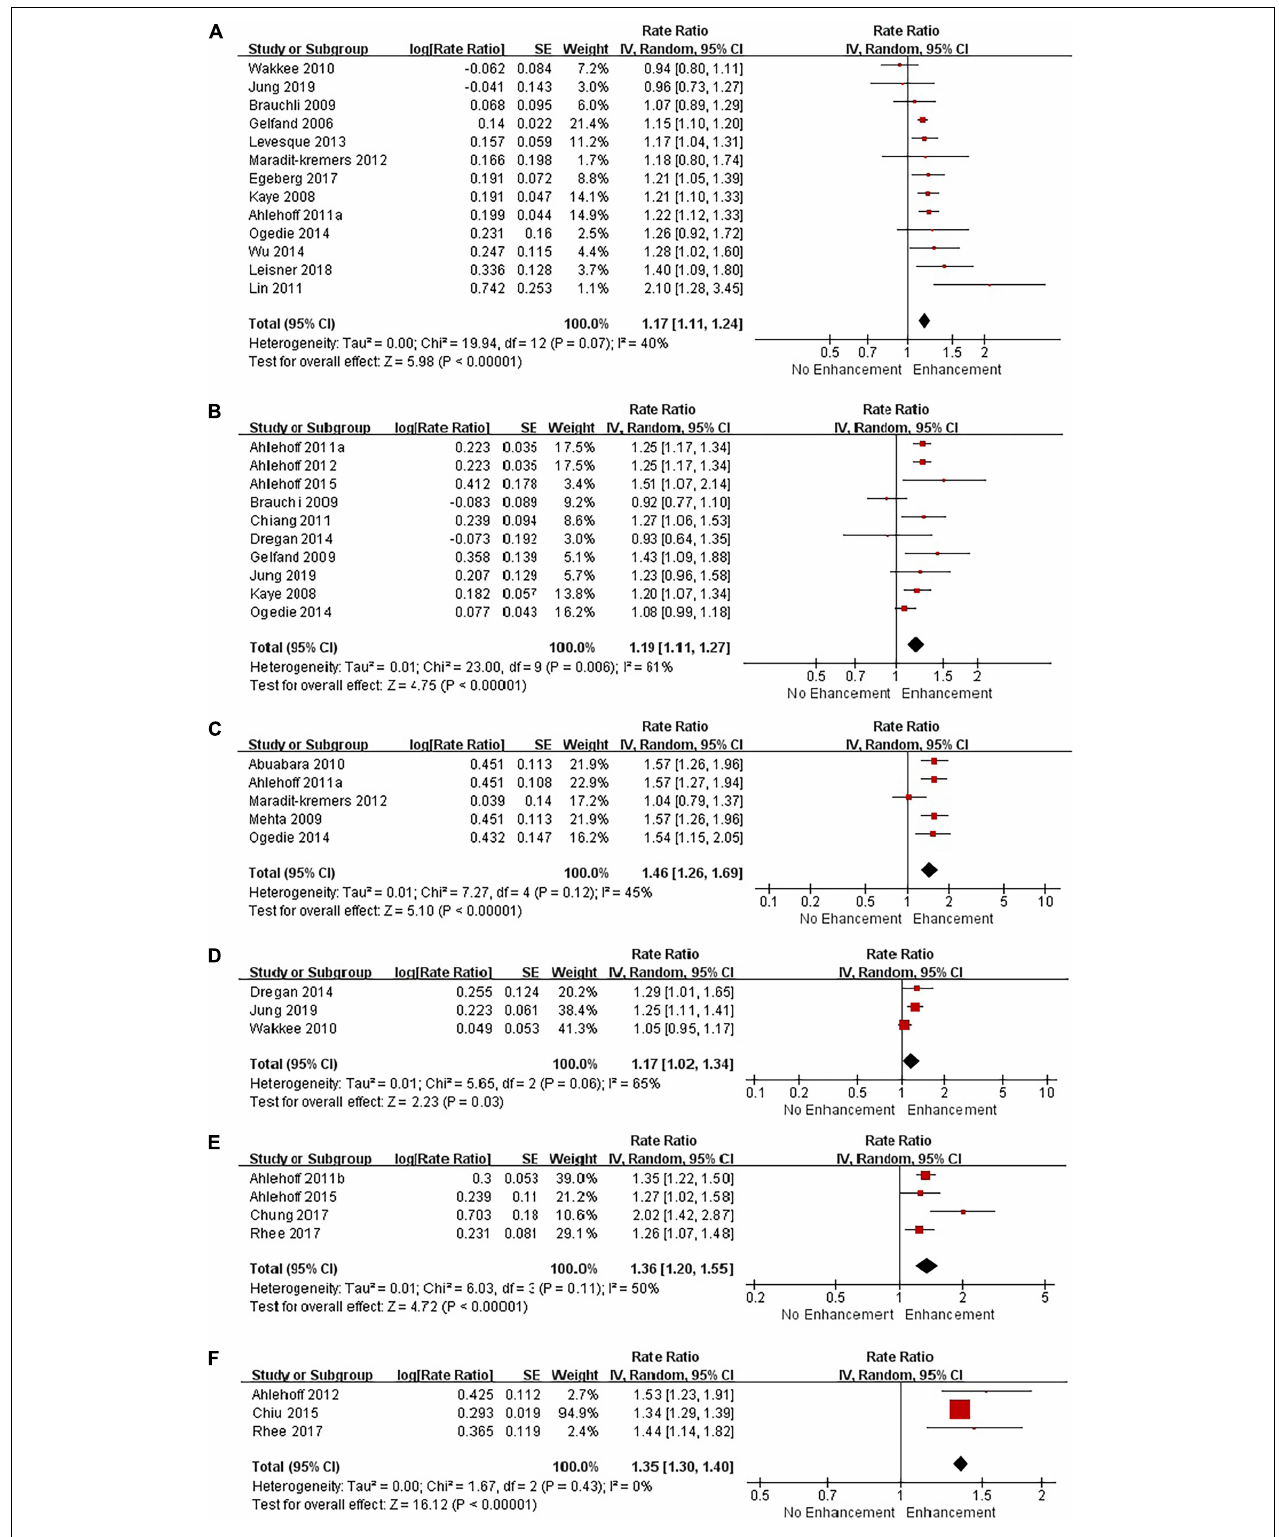
FIGURE 3 | Forest plot of adverse cardiovascular outcomes based on Review Manager. (A) Risk of myocardial infarction in patients with psoriasis; (B) risk of stroke in patients with psoriasis; (C) risk of cardiovascular death in patients with psoriasis; (D) risk of ischemic heart disease in patients with psoriasis; (E) risk of thromboembolism in patients with psoriasis; (F) risk of arrhythmia in patients with psoriasis.